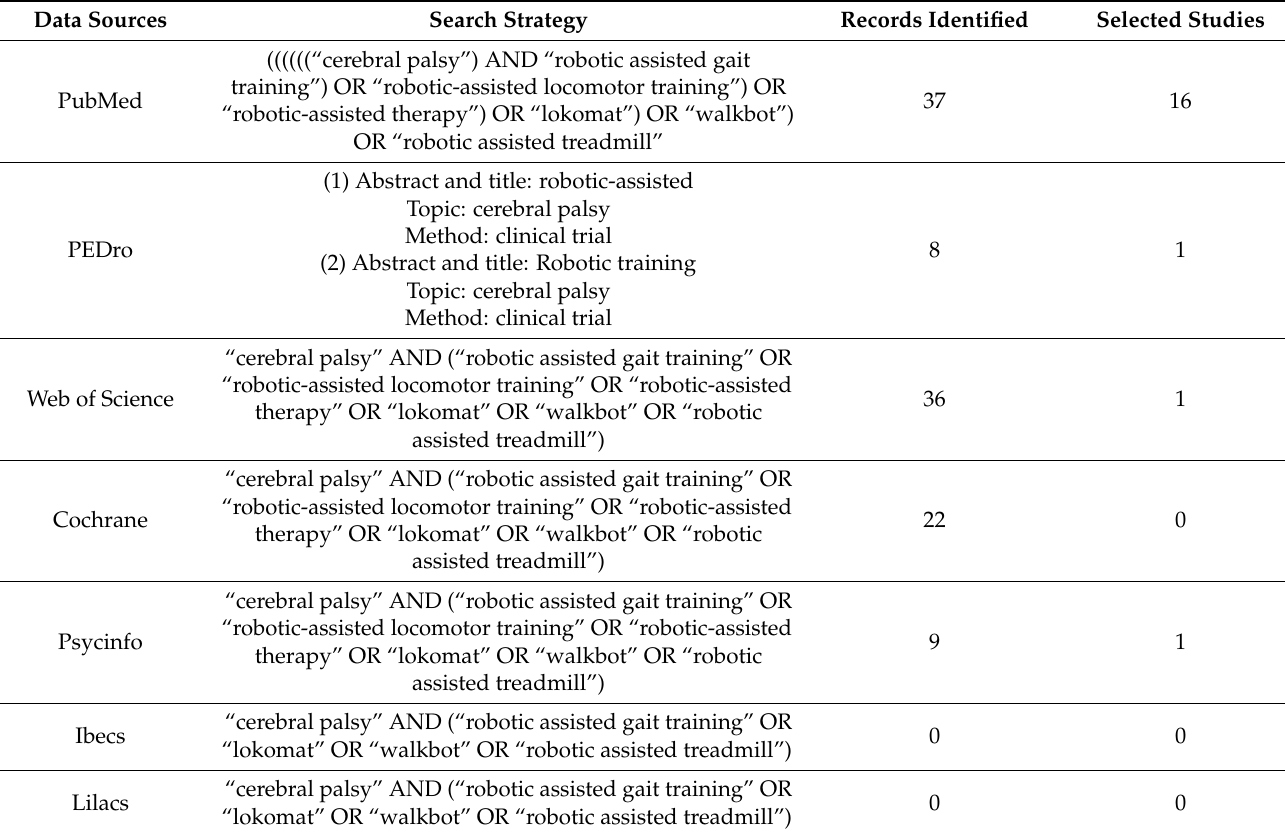
Table A1. Data sources and searches.